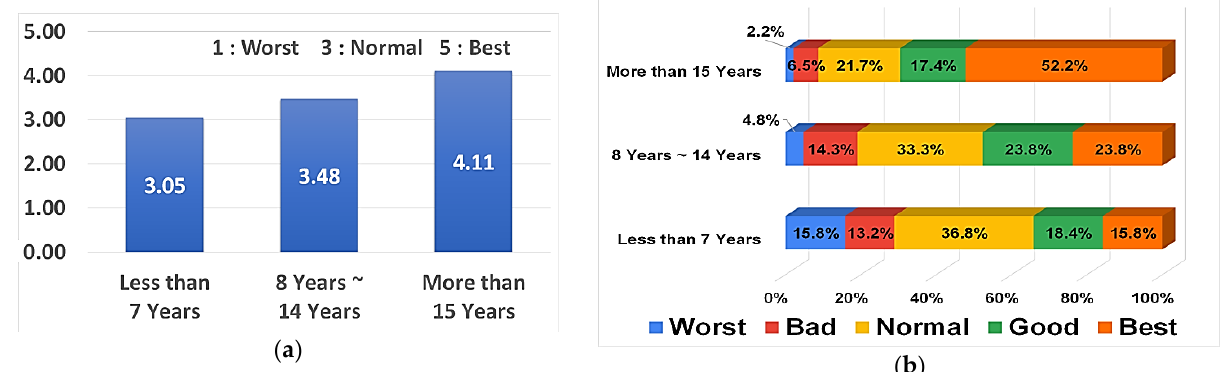
Figure A9. ( a ) Users’ understanding of the term ‘ENT’ by experience of GPS plotter usage. Average (1: Worst to 5: Best);